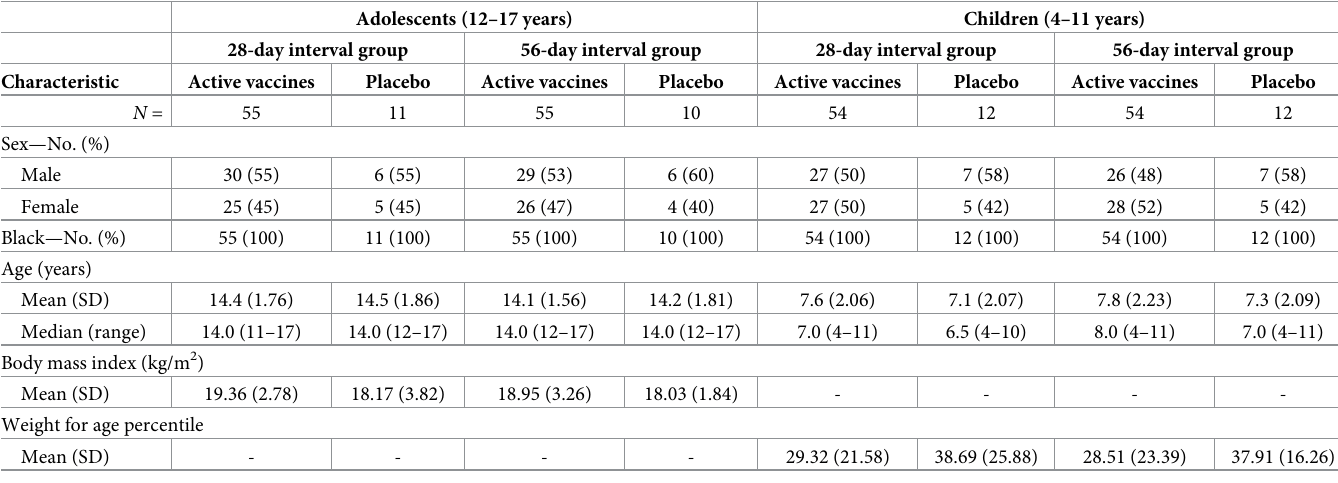
Table 1. Baseline characteristics of the participants; full analysis set �